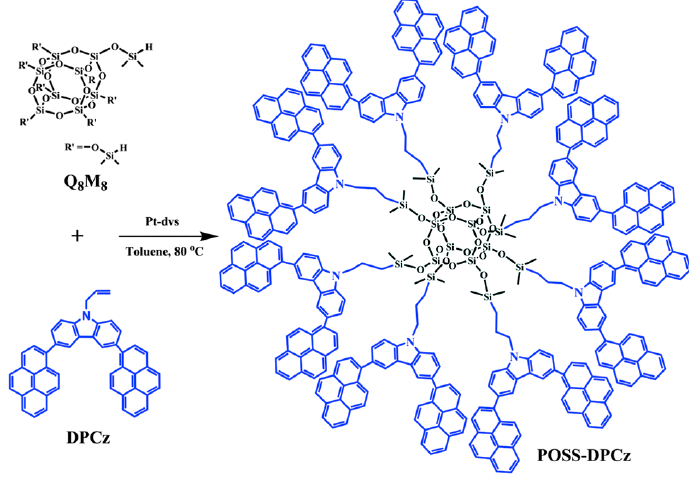
Figure 17. Synthetic procedure of POSS–DPCz [101] . Copyright 2016, Royal Society of Chemistry. A POSS-armed poly(3,4-ethylenedioxyselenophene) (EDOS − POSS) was obtained by